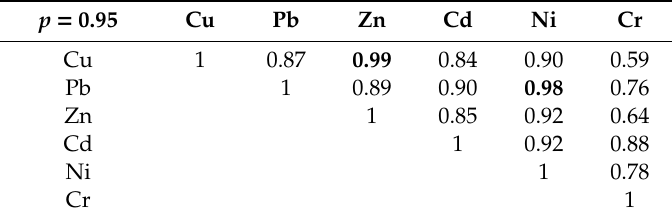
Table 4. Spearmen’s correlation of the studied trace metals.